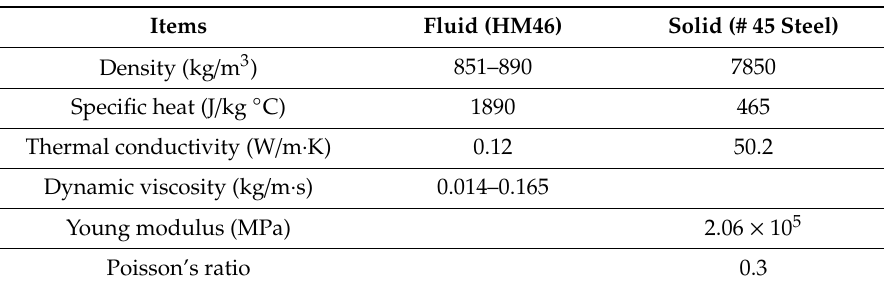
Table 2. Physical